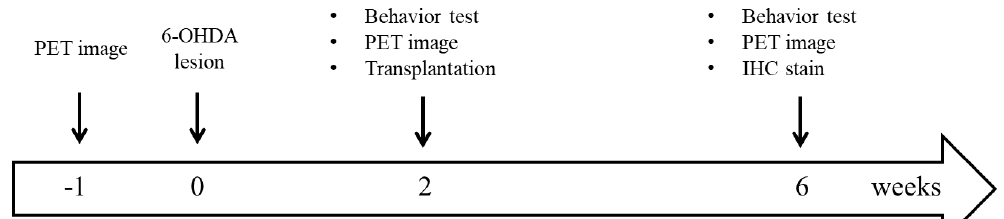
Figure 1. Experimental flowchart. [ 18 F]-DOPA and [ 18 F] FE-PE2I PET scans were performed at three time points (once before and twice after a unilateral 6-hydroxydopamine (6-OHDA) lesion was made to medial forebrain bundle of the animals). Behavior test refers to the apomorphine-induced rotation test. Transplantation was performed two weeks after the 6-OHDA lesion was made. At six weeks after the lesion, the rats were sacrificed for immunohistochemistry (IHC)